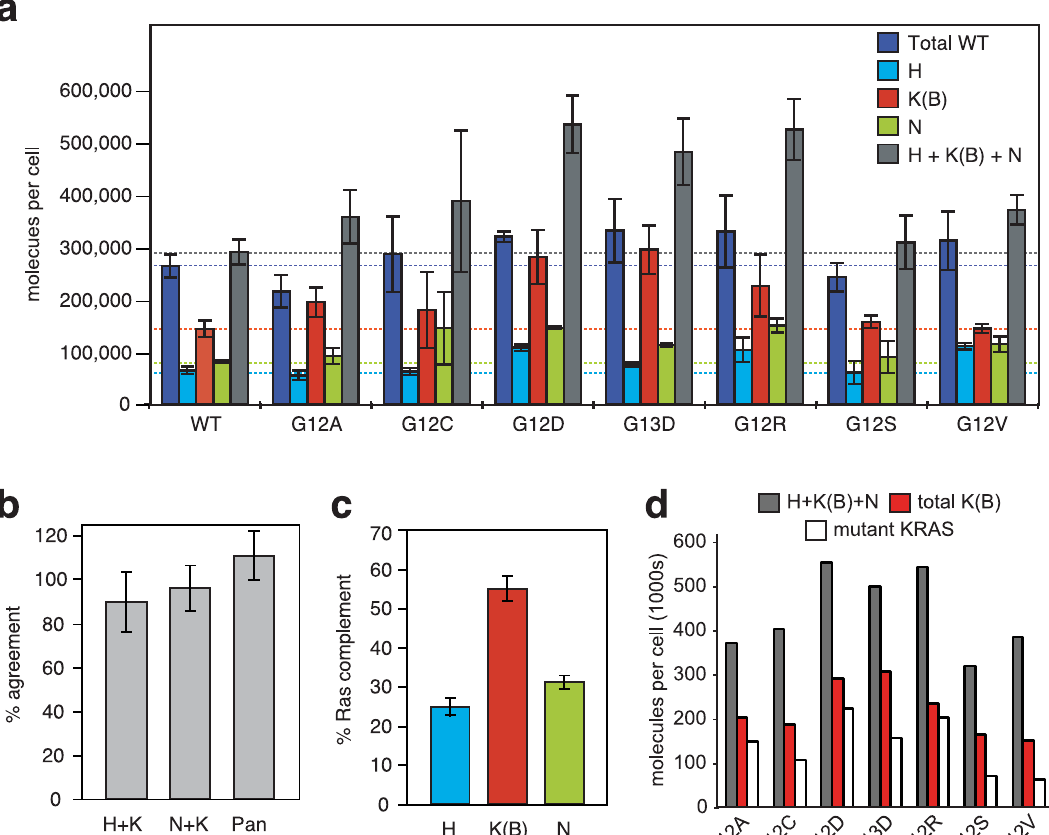
Fig 4. Cellular Ras abundance in isogenic colorectal cell lines. (A) Ras proteins are highly abundant but their levels vary across a panel of isogenic SW48 cells harbouring different oncogenic mutations in KRAS. Horizontal lines indicate the wild-type cell lines to aid comparison. (B) Quantitation of isoform- specific peptides is corroborated by peptides shared between isoforms. Percentage agreement was calculated as ((isoform-specific peptide + isoform- specific peptide) / shared peptide) × 100. Shared peptides were TGEGFLCVFAINNTK (HRAS and KRAS), SYGIPFIETSAK (KRAS and NRAS) and LVVVGAGGVGK (all wild-type isoforms). n (cid:1) 20 for H+K and N+K, n = 3 for Pan as only applicable to the wild-type Ras SW48 cell line. Bars represent mean ± SD. No significant difference (p > 0.01 paired T-test) is observed between the total estimated molecules per cell of HRAS peptide + KRAS isoform- specific peptidse versus the HRAS/KRAS shared peptide, NRAS + KRAS isoform specific peptides versus KRAS/NRAS shared peptide and H+K+N isoform specific peptides versus the wild type Pan-Ras peptide. (C) KRAS represents > 50% of total cellular Ras in the wild-type Ras SW48 cell line. For each graph in each panel, bars represent mean ± SD of (cid:1) 3 biological replicates. (D) Number of calculated mutant KRAS molecules changes between cells harbouring different KRAS mutations. Mutant KRAS levels were calculated by subtracting number of wild-type RAS molecules from the sum of H+K(B)+N isoform specific